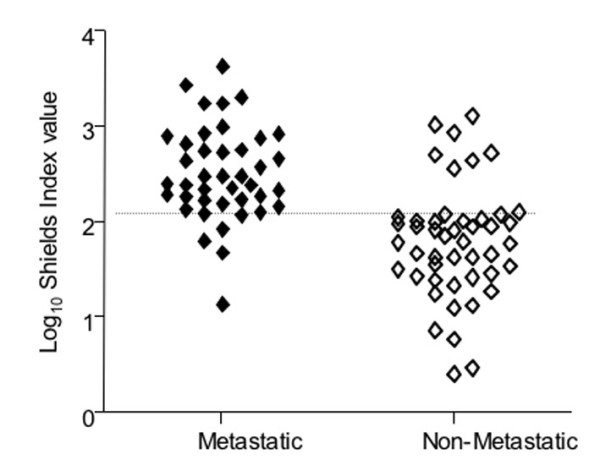
Shields Index values scatterplot. The Shields Index values, for all 106 patients assessed, were plotted on a scatterplot to represent the spread in Shields Index values for the metastatic and non-metastatic groups. The Shields Index (calculated from epi-tumoural LD, lymphatic vessel invasion and Breslow thickness). With a cut off point of 2.10, 92 of the 106 samples are correctly predicted (86.8%) with only 14 samples predicting incorrectly. A total of 5 patients that later developed metastases were predicted to be non-metastatic and 9 patients that have not yet developed metastases are predicted to do so.